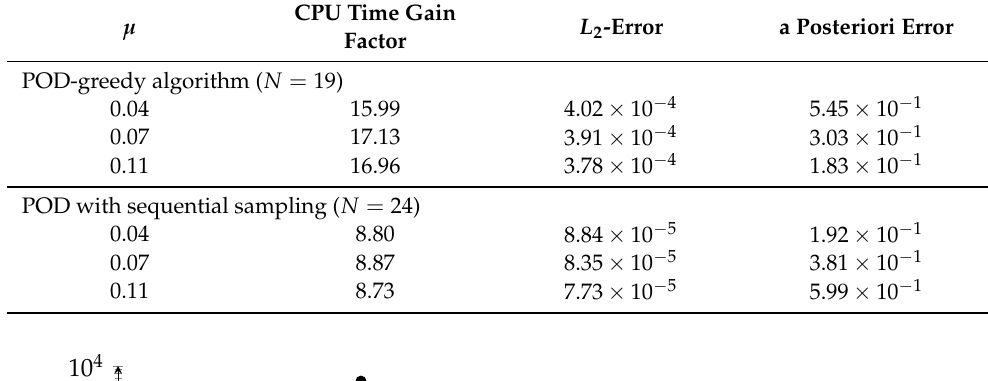
Figure 1. Plot of the value of the a posteriori error estimator max ∆ N offline stage computed by the POD-greedy algorithm. The dimension of resulting reduced basis is N = 19, ε tol = 1 (Experiment I). Table 2. CPU time gain factor and approximation error between the truth and the reduced basis solution at t = T end with a reduced basis of dimension N . The reduced basis is computed with a POD-greedy algorithm (Experiment I).